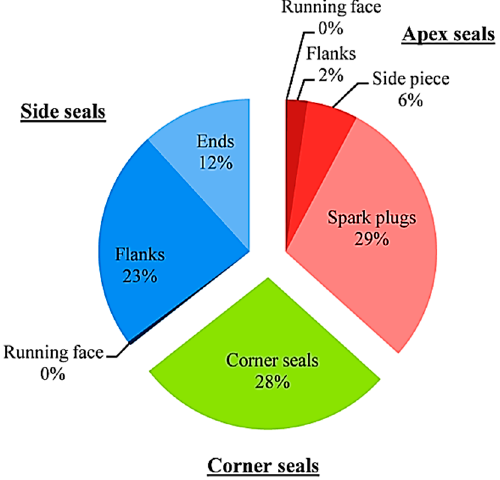
Figure 7. Sealing leakage estimation (Picard et al. [70]).